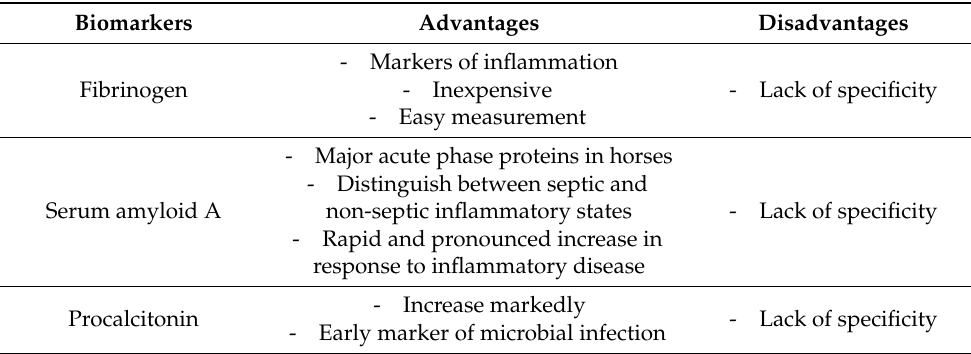
Table 5. Summary of advantages and disadvantages of main biomarkers currently used to diagnose